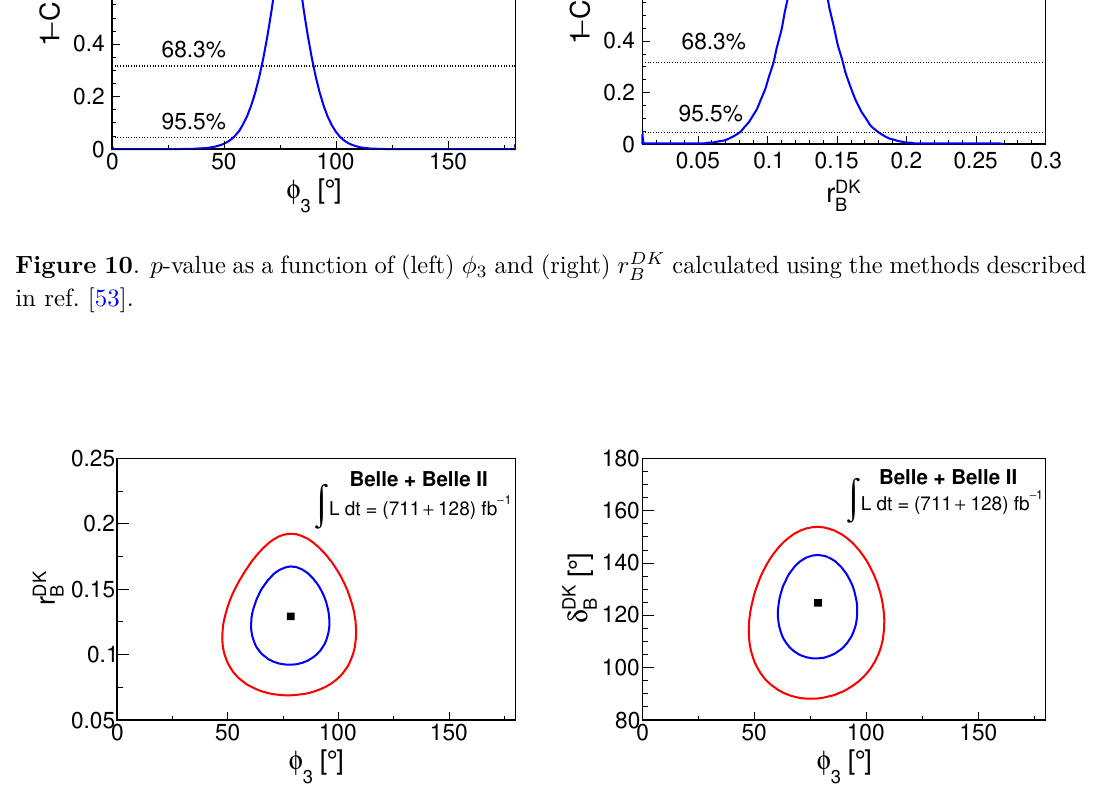
Figure 11 . Two-dimensional confidence regions at the (inner curve) 68% and (outer curve) 95%, obtained for (left) φ and (right) φ using the methods described in ref. [53]. Note DK DK 3 − r 3 − δ B B the suppressed zeroes on the vertical